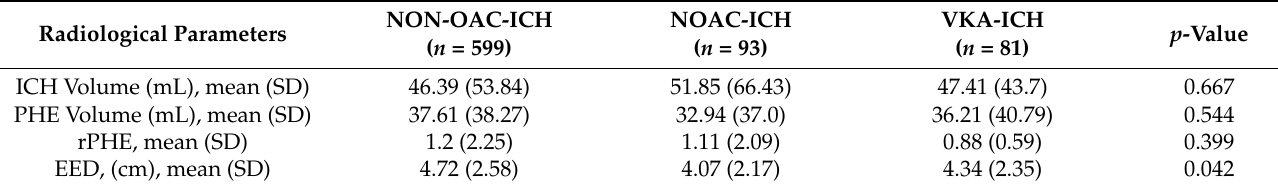
Legend: ICH indicates intracerebral hemorrhage; EED, edema extension distance; PHE, perihematomal edema; rPHE, relative perihe- matomal edema; NOAC-ICH, non-vitamin K dependent oral anticoagulation associated intracerebral hemorrhage; NON-OAC-ICH, non-oral anticoagulation related intracerebral hemorrhage; SD, standard deviation; and VKA-ICH, vitamin K antagonists associated intracerebral hemorrhage. Please note: the number of patients ( n = 599) displayed refers only to those with documented type of oral anticoagulation ( n = 212 out of n = 811 were